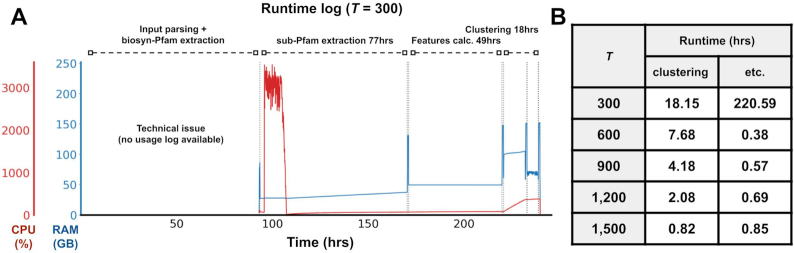

(A) Runtime breakdown of the full run (T = 300) on a 36-core CPU, 262 GB RAM server. Owing to some technical issues, no usage log is available for steps prior to the sub-Pfam extraction. CPU usage log shows that most of the time, BiG-SLiCE only uses 1 CPU core, giving room for further improvement, e.g., via SQL parallelization. Spikes in the RAM usage (peak = ∼150 GB) came from the periodic “dumping” of the in-memory database (used to speed up runtime) into an SQLite db file. (B) Runtime comparison between multiple runs, with T = 300 bearing the full load of performing input processing and feature extraction. Here, runtimes are separately shown for both the clustering (GCF model construction + membership assignment) and other steps (input parsing, hmmscanning, and feature extraction).